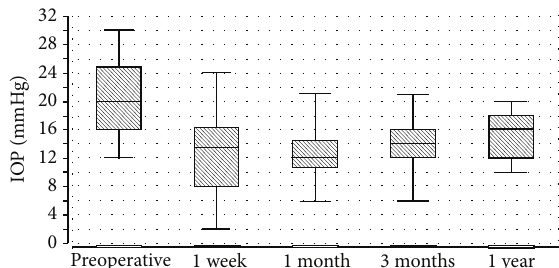
Figure 2: Course of the intraocular pressure after the surgery. Box plots indicate the minimum and maximum, as well as the 25% and 75% quartiles.